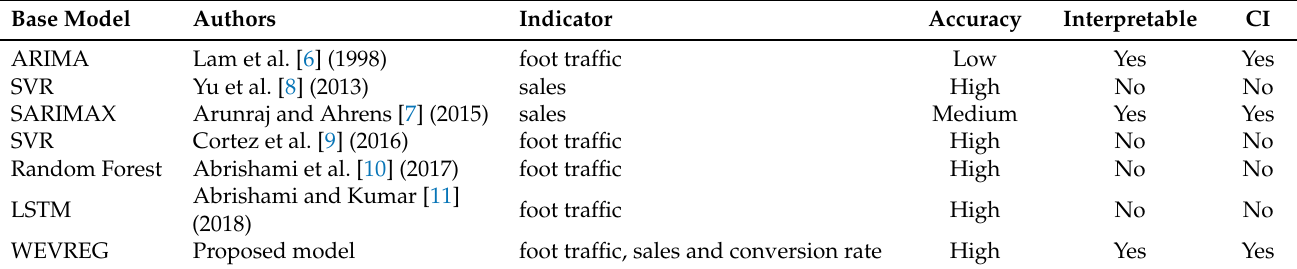
Table 9. Comparing retail forecasting